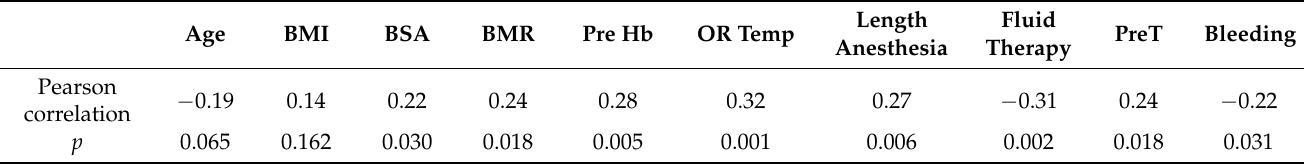
Table 3. Correlation between EndT and characteristics of patients and perioperative variables.